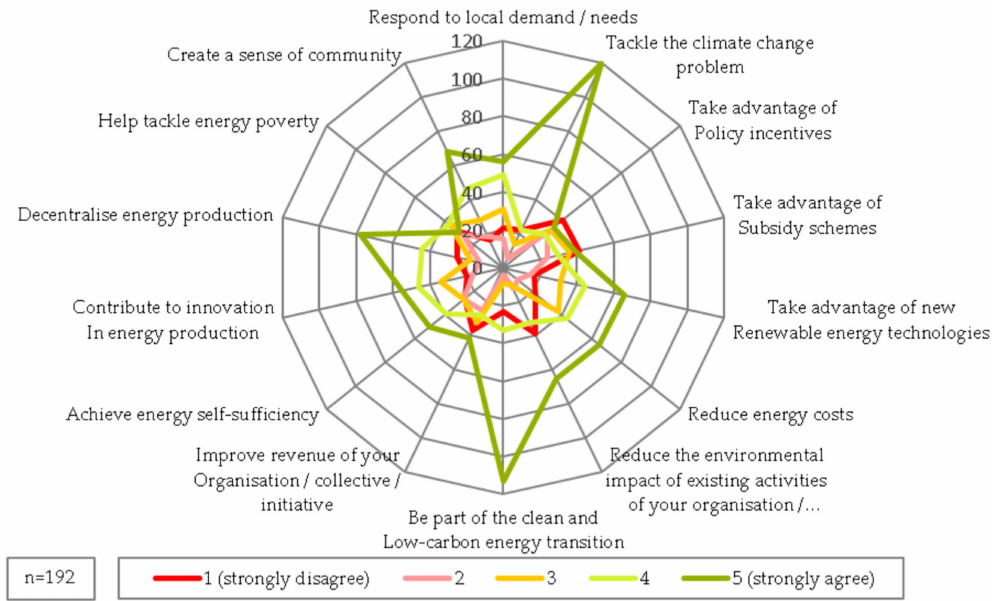
Figure 12. Main reasons for starting a prosumer